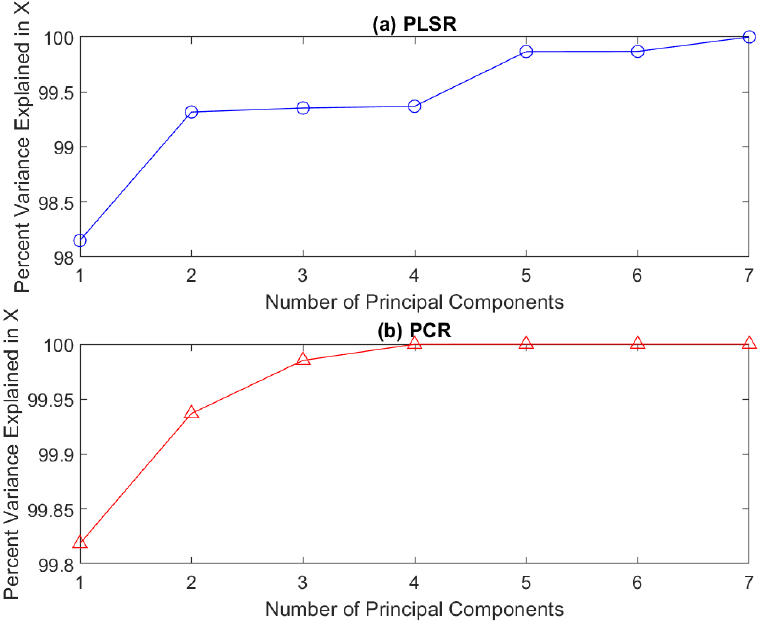
Figure 9. Correlation matrix of training data.